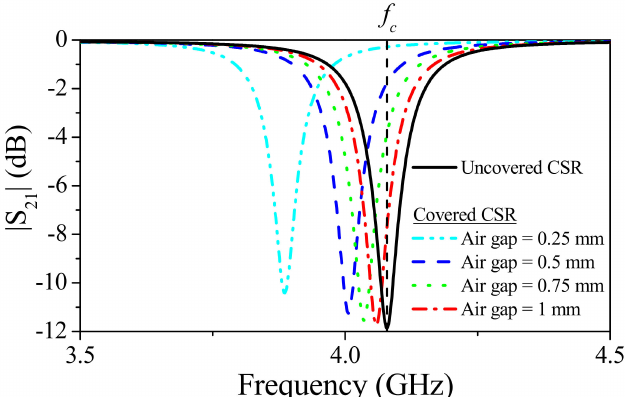
Figure 9. Simulated (by means of the Ansys HFSS commercial software) transmission coefficient of the bare complementary spiral resonator (CSR), and covered CSR by considering different air gaps. Reprinted with permission from [22]. Copyright 2019 IEEE.